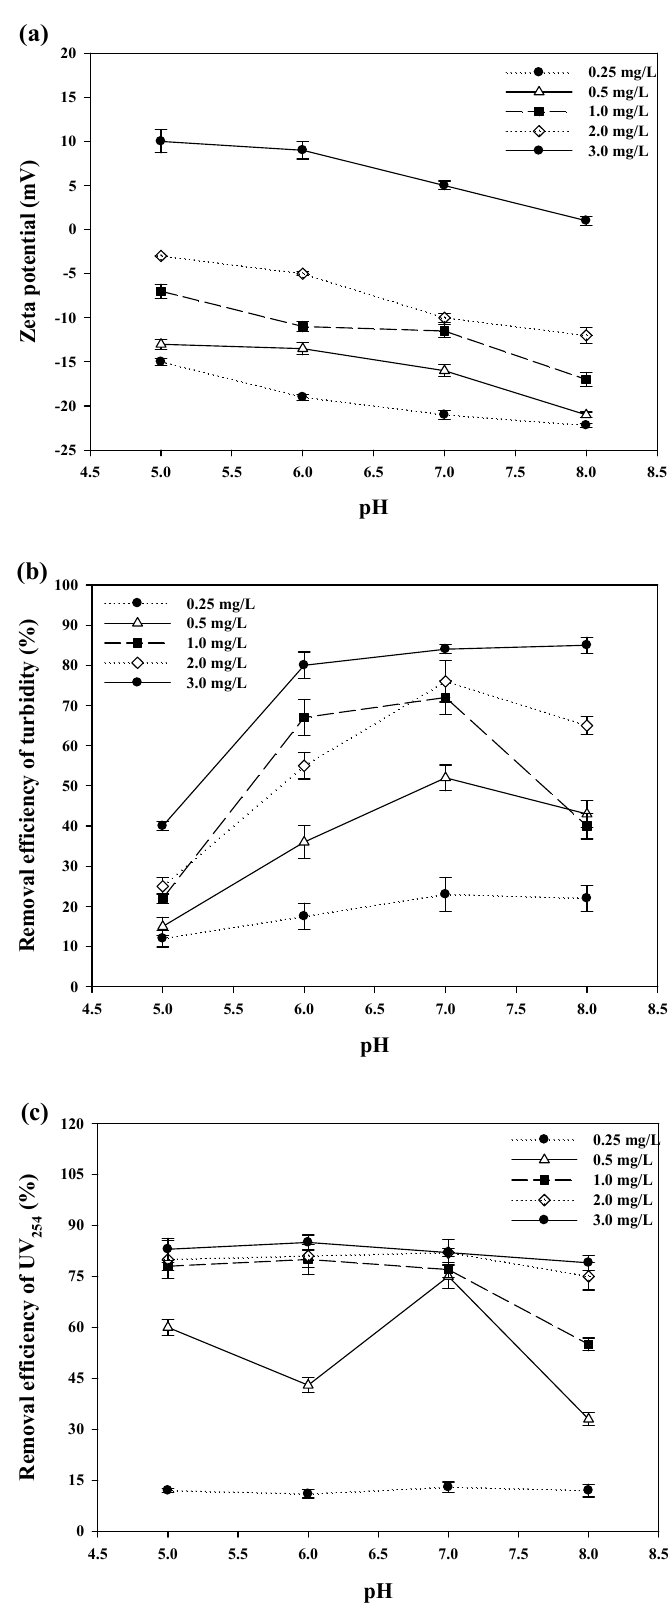
Figure 2. Results of the jar test, conducted after changing the coagulation dosage and pH: ( a ) Zeta potential variation and removal efficiencies of ( b ) turbidity and ( c ) UV 254 .